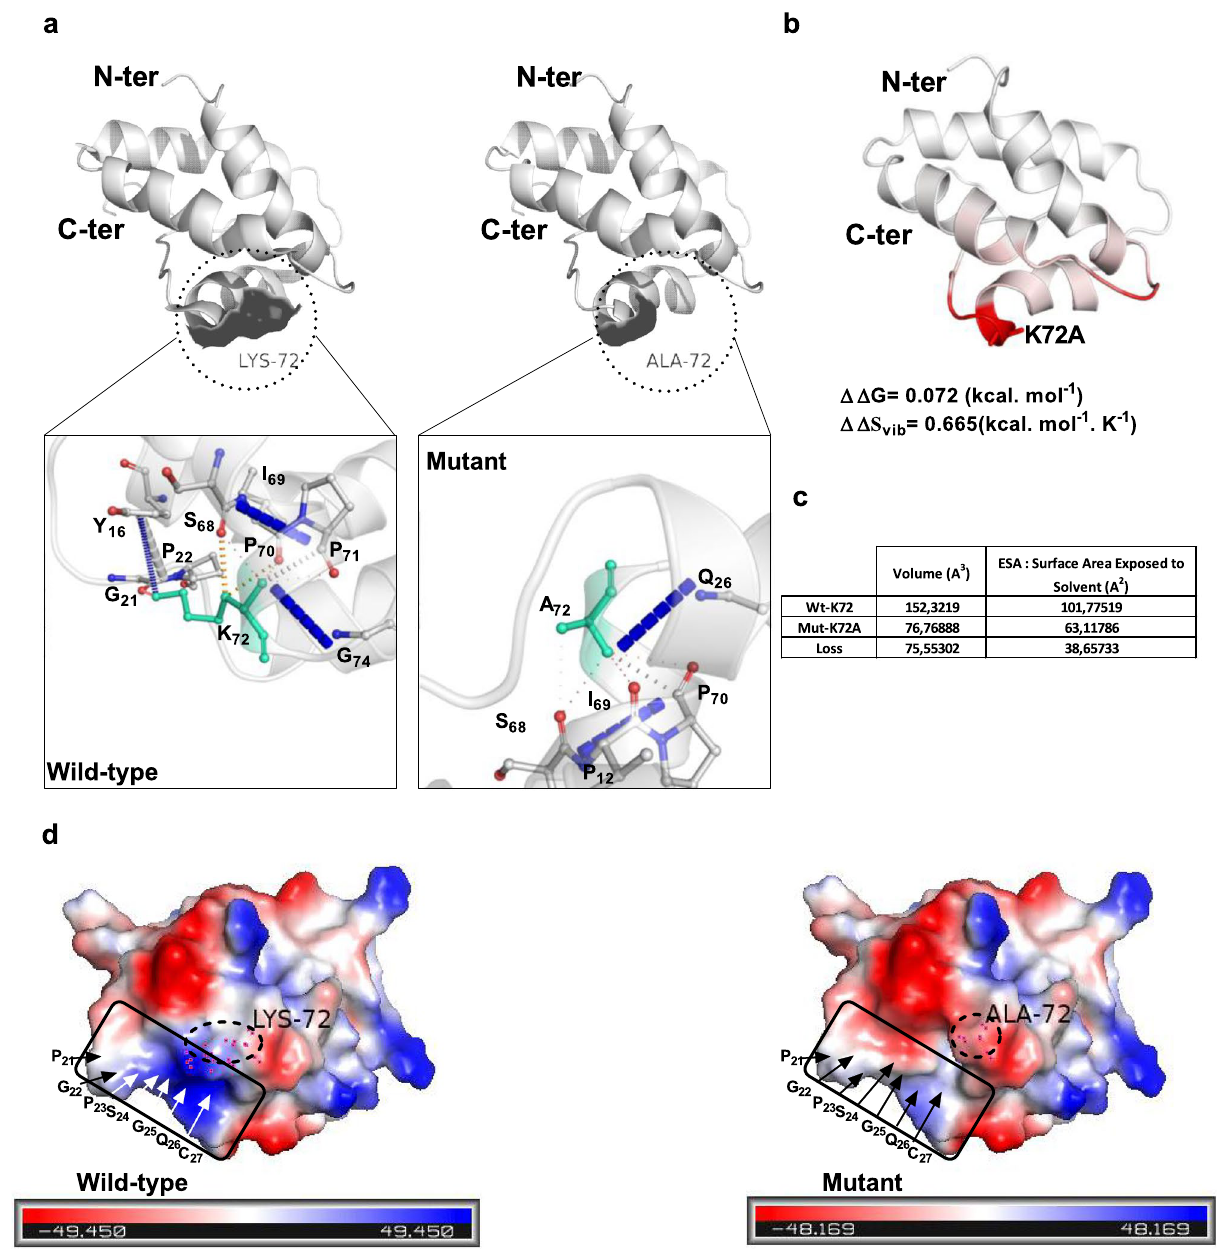
Figure 6. Interaction, surface and thermodynamic properties of the K72A LTP1 variant. ( a ) Wt-LTP and K72A variant 3D structures and interaction network predicted using the DynaMut web tool. The surface topology (upper panel) and the different residues affected by mutation are indicated (lower panel). ( b ) 3D structure showing the vibrational entropy of the K72A variant. Red indicates an increase in entropy. The predicted values of enthalpy (ΔΔG) and vibrational entropy (ΔΔS vib ) appear below the 3D model. ( c ) Volumetric properties of Wt-LTP and K72A variants determined by the VLDP web server. The values and differences in volume and surface area exposed to solvent between wild-type and K72A variants are indicated. ( d ) Electrostatic properties of Wt-LTP and K72A variants were generated using PyMol. Red: negative charge; blue: positive charge. Boxes highlight the zone of major